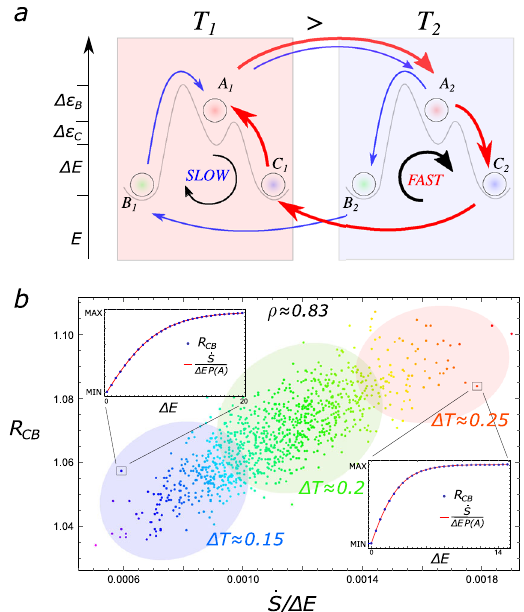
Fig. 2 Features connecting dissipation and selection in a three-state two- box model. a Diffusive cycles convert thermal energy into chemical energy. The direction and thickness of each arrow represent respectively direction and intensity of the net probability fl ux between two states. b Correlation between R CB = P ( C )/ P ( B ) and _ S = Δ E , which is the steady state entropy production divided by the characteristic energy scale of the system, for different values of Δ E and Δ T . Here, Δ ϵ = 2, T m = 0.7, d → + ∞ , both Δ E and Δ T have been drawn from a normal distribution of mean 1 and 0.2, with a variance of 0.1 and 0.02, respectively. Identical values of the gradient correspond to the same color. ρ is the correlation coef fi cient. We report the approximate average Δ T among the values contained in each shaded area. Insets - Setting Δ T = 0.15 (top) and Δ T = 0.25 (bottom), we show that R and _ S Δ EP ð A Þ exhibit the same behavior as a function of Δ E , when plotted within the same range, extending Eq. (9) beyond the small gradient regime. The Boltzmann coef fi cient has been taken equal to 1 for